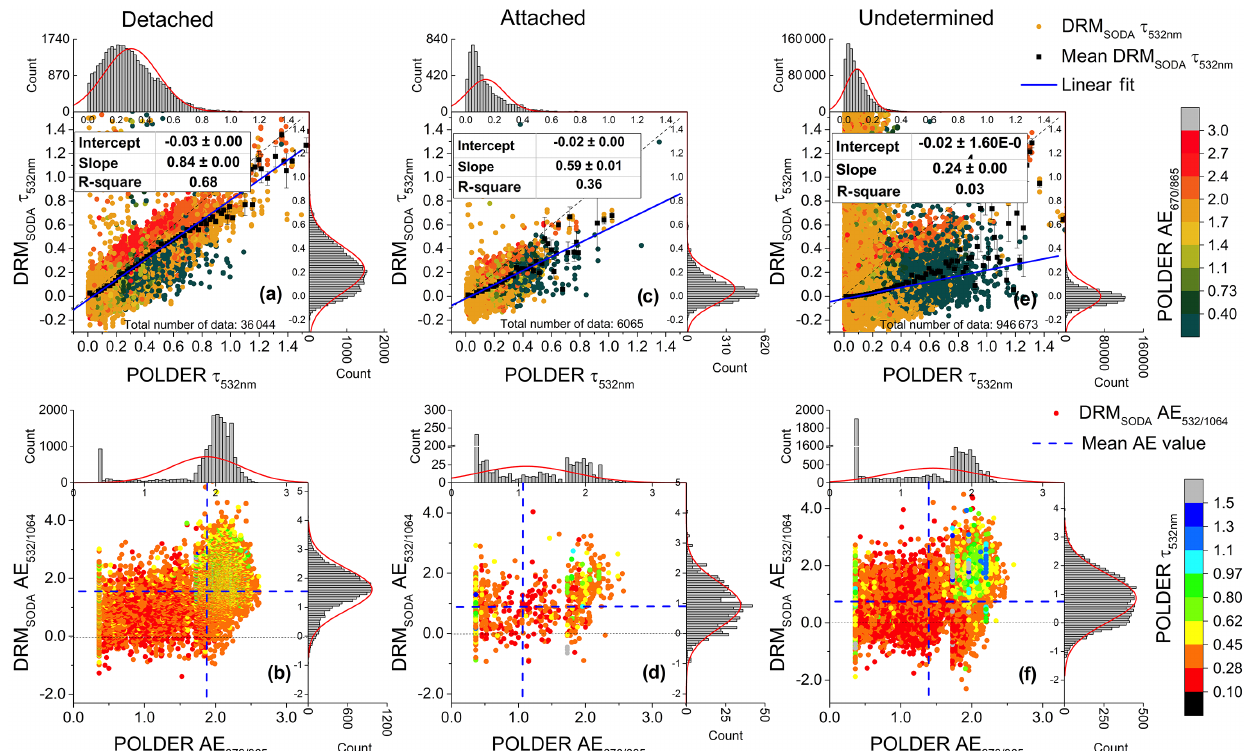
Figure 5. Global comparison over a period of 4.5 years (June 2006–December 2010) for situations with aerosol layer well separated from the cloud top (“detached”; a, b ), for cases where the aerosol layer is in contact with the cloud (“attached”; c, d ) and for “undetermined” situations (e, f) . The comparison of AOT at 532nm retrieved from DRM SODA and POLDER methods is shown in the first row. The colour scale represents the corresponding POLDER AE computed between 670 and 865nm. The second row presents the Ångström exponent for AOTs larger than 0.1, with a POLDER AOT at 532nm colour scale. The histograms present the data distribution. The error bars in (a) , (c) and (e) represent the standard error of the mean